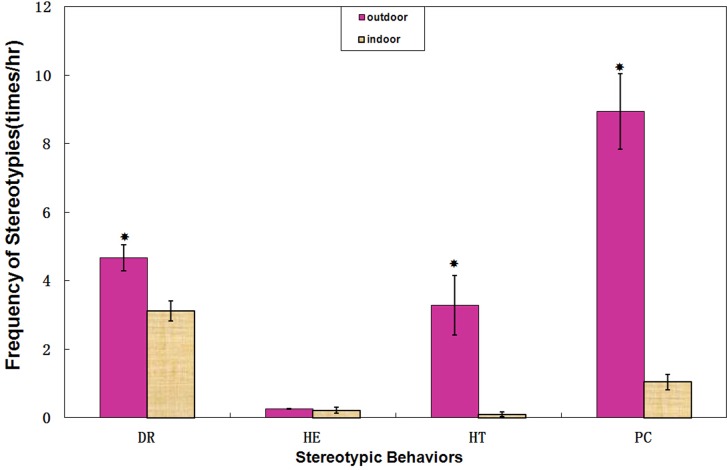
The frequency of different stereotypy in outdoor enclosures and indoor enclosures.The dark column represents the proportion of stereotypies in outdoor enclosures. The wall column respresents the proportion of stereotypies in indoor enclosures. Standard errors are represented in the figure by the error bars attached to each column. There was a significant difference in the frequency of Door-direct, Head-toss and Pacing between outdoor enclosures and indoor enclosures(P<0.05).